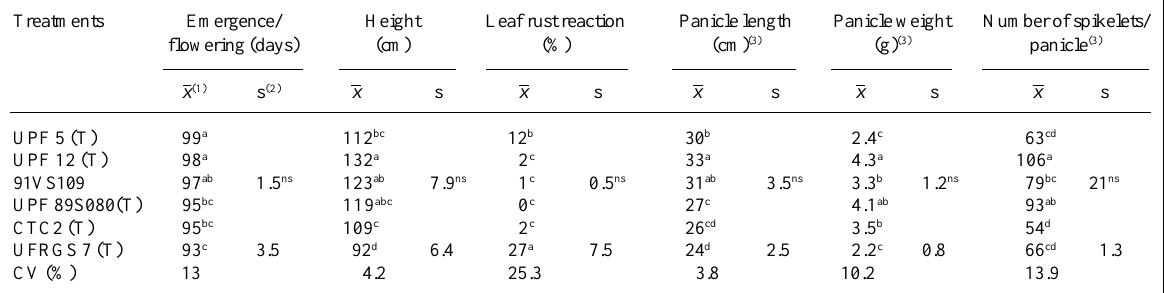
Table VI - Comparison between means and standard deviations from oat somaclone 91VS109, derived from cultivar UFRGS 7, and controls. Evaluated traits were: days between emergence and flowering, plant height, leaf rust reaction, panicle length and weight and number of spikelets per panicle. Experiment 3. EEA/UFRGS, Eldorado do Sul, RS,